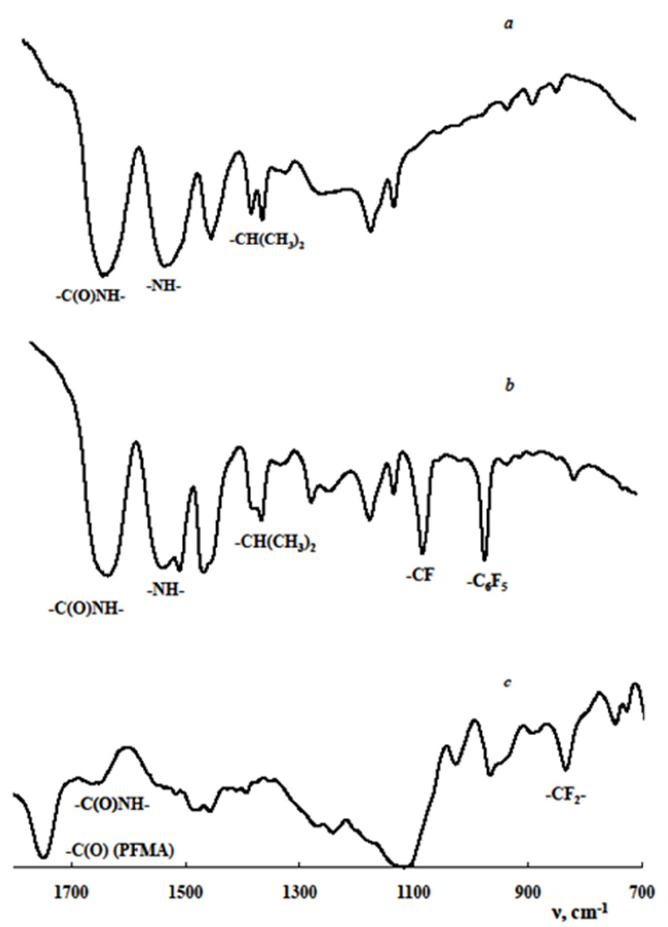
Figure 1. Fragments IR spectrum of ( a ) PNIPAAm, ( b ) the functional polymer PNIPAAm–Ge(C 6 F 5 ) 2 H and ( c ) the linear block copolymer PNIPAAm–Ge(C 6 F 5 ) 2 ‒ PFMA.